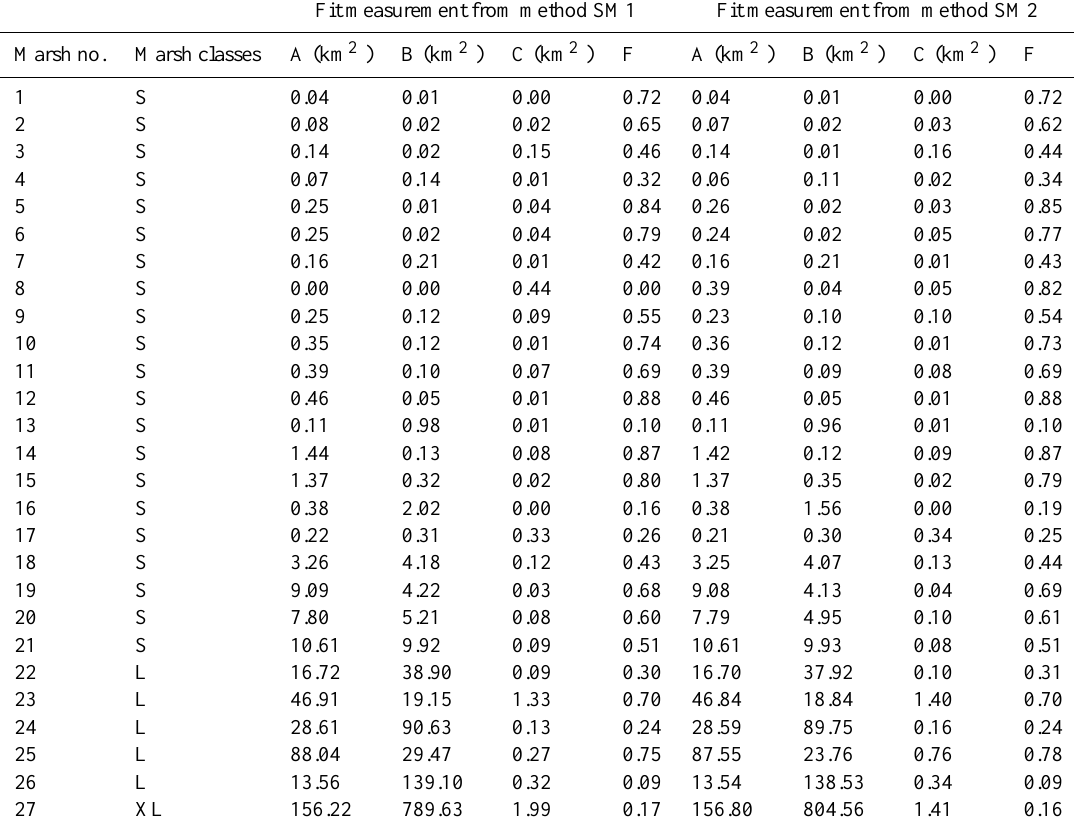
Table 4. Results of fit measurements computation for the 27marshes, classified into three classes: small marshes (S), large marshes (L) and very large marshes (XL), using methods SM1 and SM2.